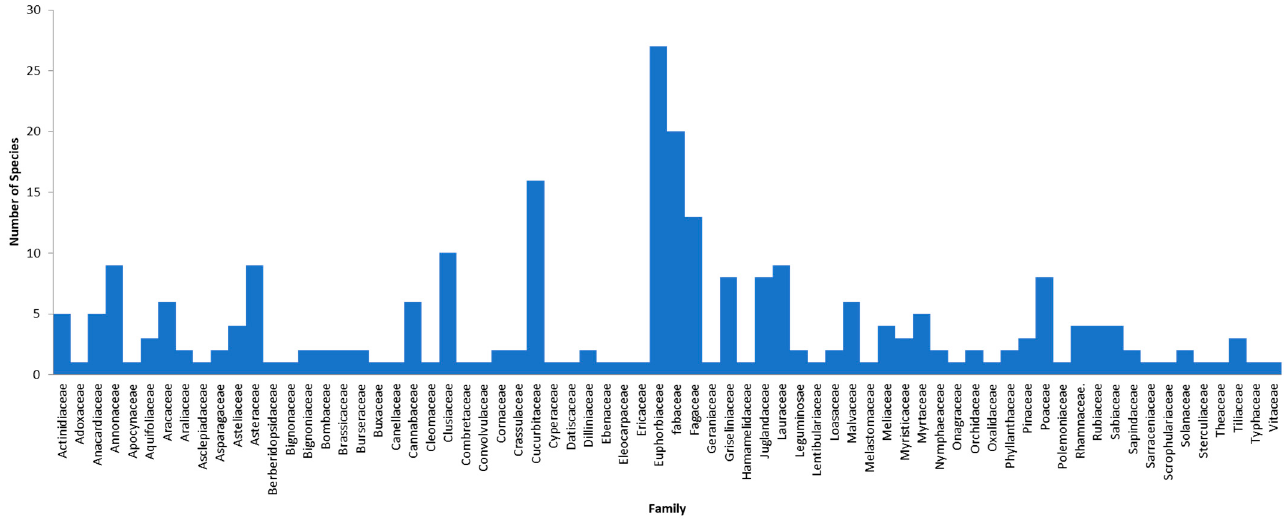
Figure 3. Families of plant species based on trnL result.